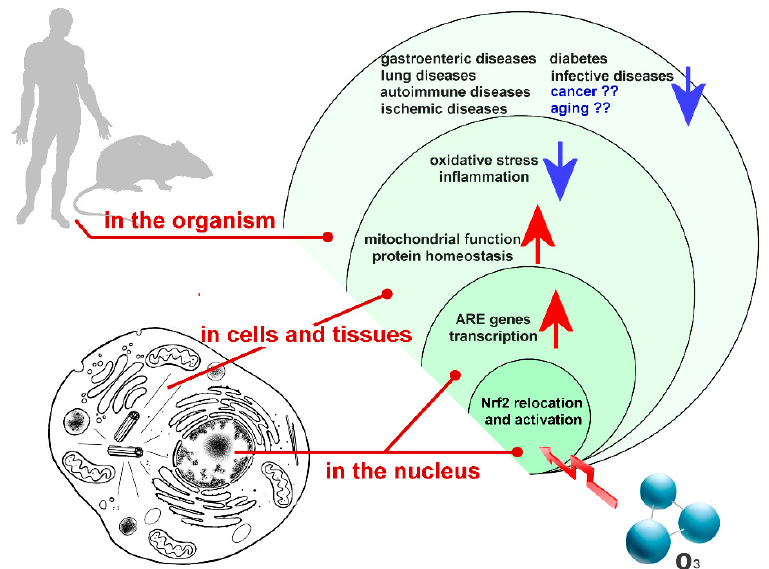
Figure 1. Main functional pathways depending on Nrf2 activation induced by low ozone concentrations. Arrows indicate up- (red) or down- (blue) regulation.